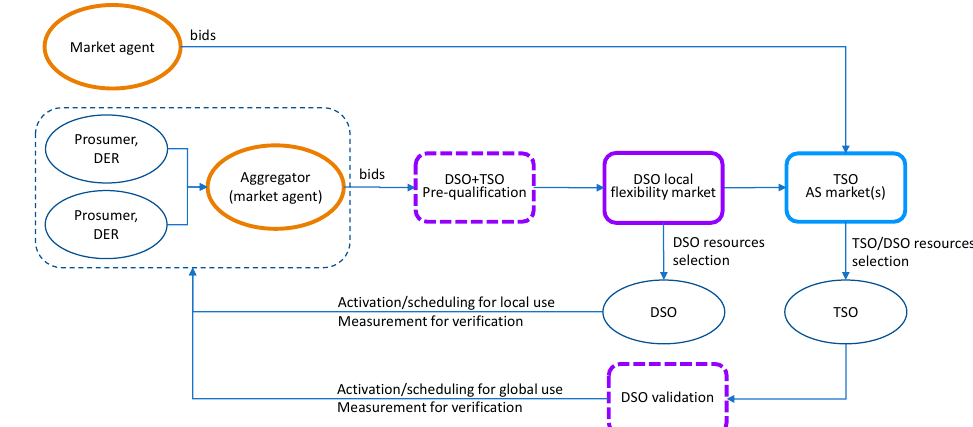
Figure 3. Local (DSO) and global (TSO) flexibility markets with resources sharing (M2).